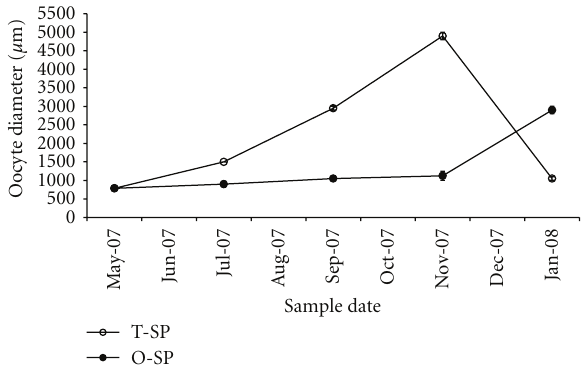
Figure 3: Oocyte diameter during rainbow trout oogenesis. O-SP: once spawners; T-SP: twice spawners (mean ± SE, n =